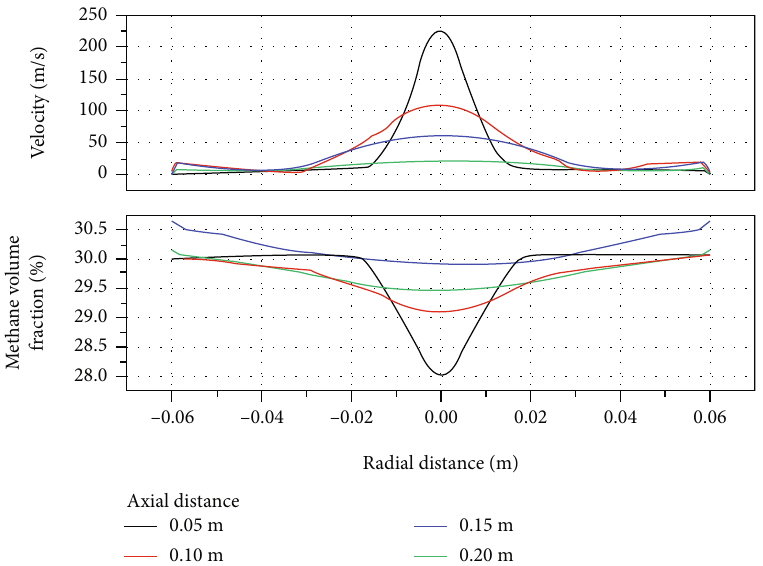
Figure 4: Methane volume fraction and fl uid velocity along the radial direction in